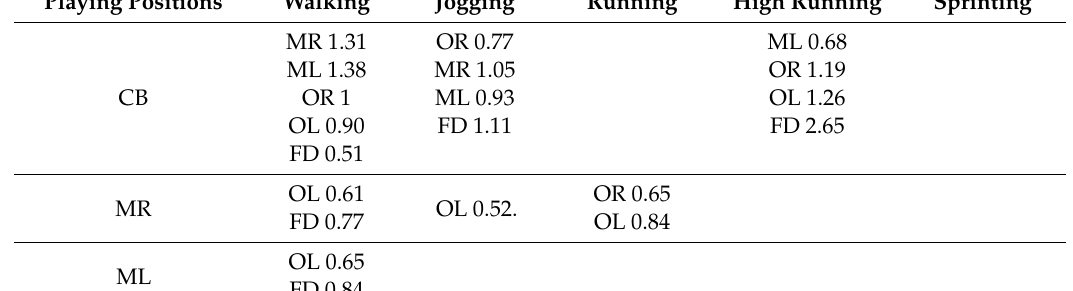
Table 3. E ff ect sizes in di ff erent locomotion categories by playing position in Table 3. Effect sizes in different locomotion categories by playing position in defense. Playing positions